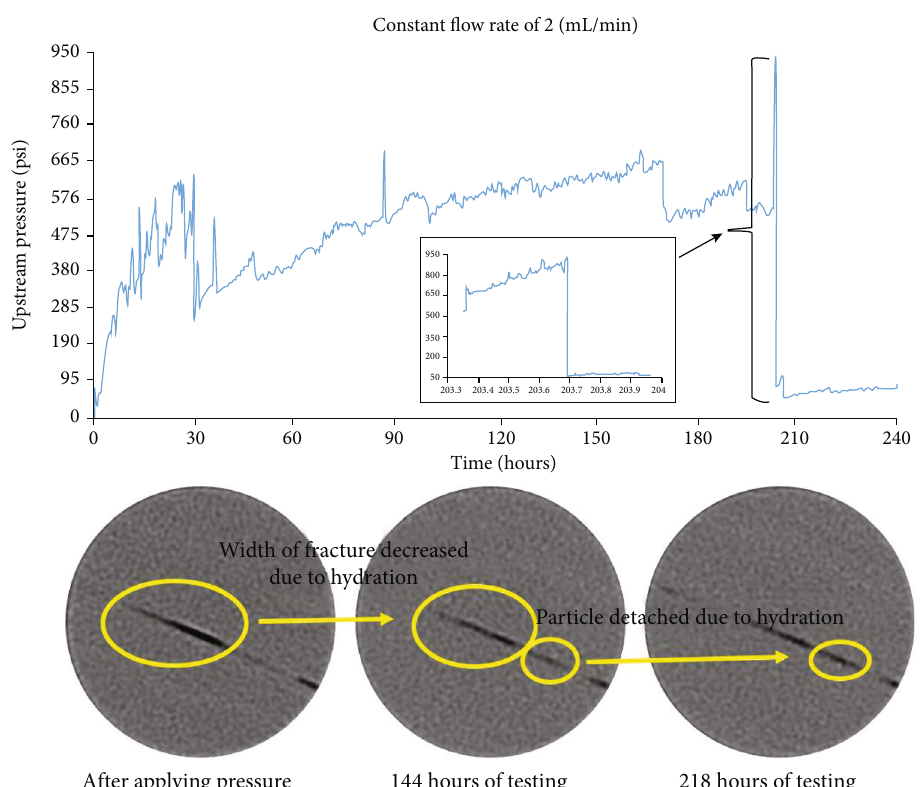
Figure 22: Another testing result from Liu and Sheng [12].